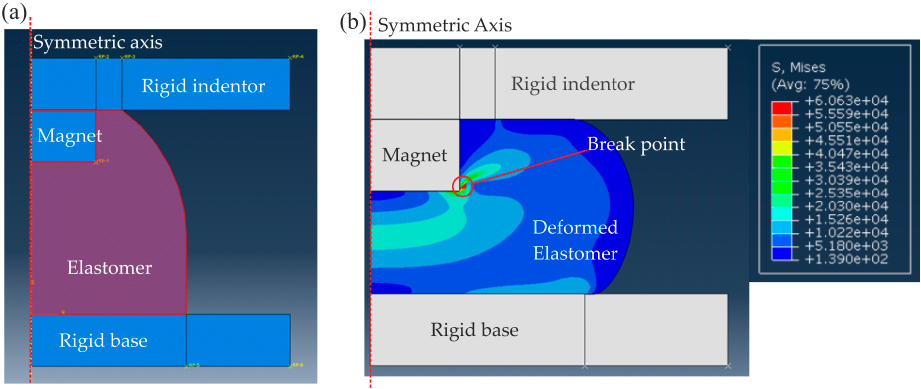
Figure 5. ( a ) 2D symmetric FE model of the elastomer when it is fixed on a rigid base and indented by a rigid flat surface; ( b ) The von Mises stress distribution in the elastomer when it is indented by 3